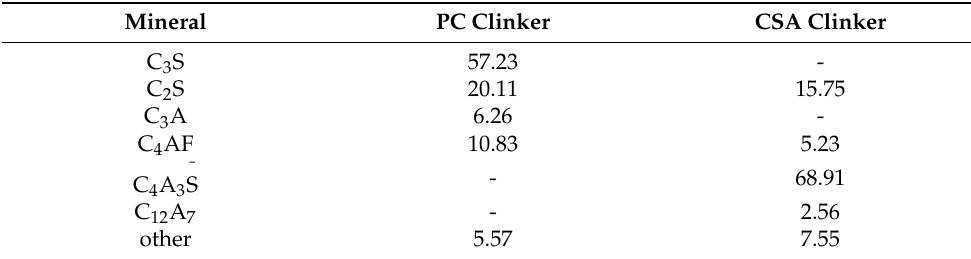
Table 2. Main mineral composition of PC and CSA clinker